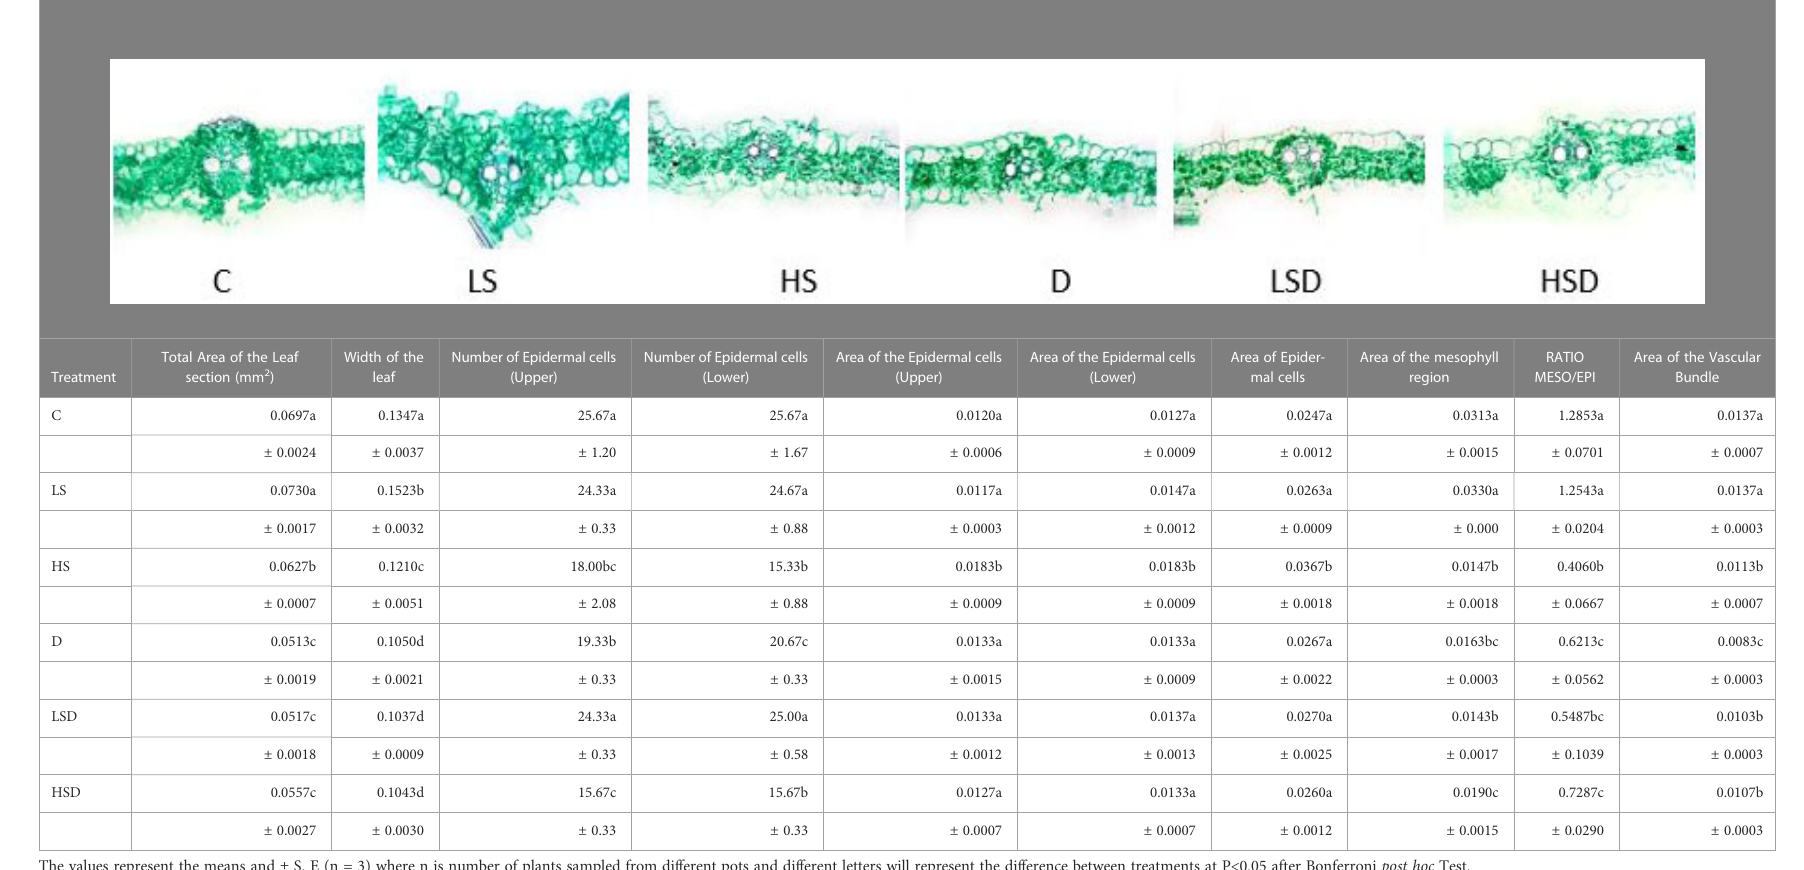
The values represent the means and ± S. E (n = 3) where n is number of plants sampled from different pots and different letters will represent the difference between treatments at P<0.05 after Bonferroni post hoc